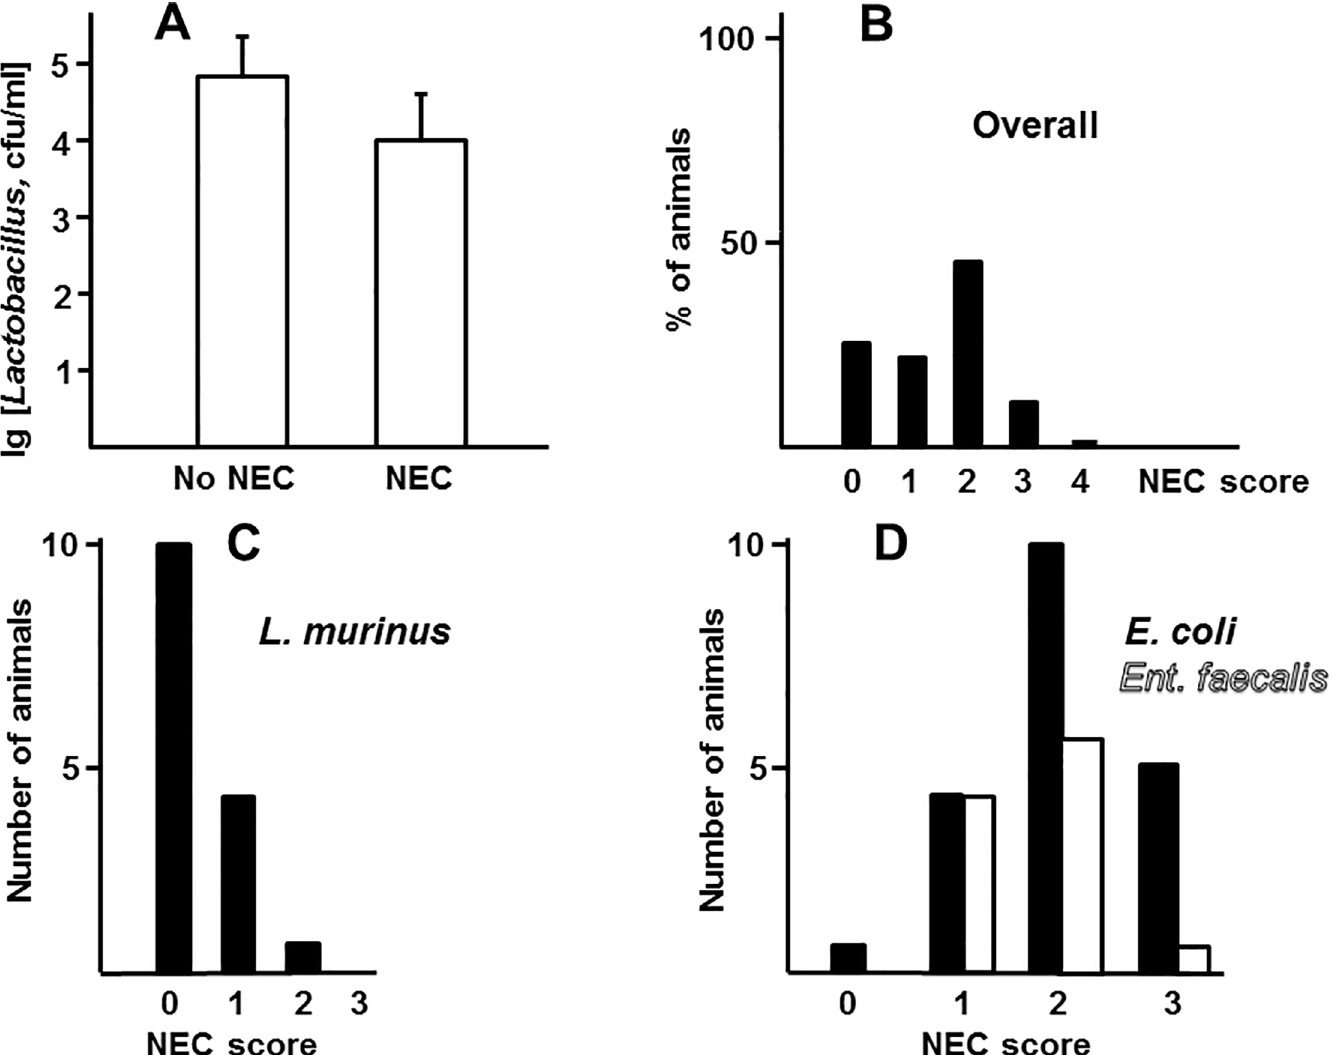
Fig 2. Association of NEC with lactobacilli. A, average logarithms of Lactobacillus loads in healthy (NEC scores 0–1, n = 18) and sick (NEC scores 2–4, n = 28) animals. Differences between groups are not significant, p = 0.36, unpaired Student’s t test. B-D, distribution of NEC scores in the whole study cohort (B, n = 46) and in groups harboring L . murinus (C, n = 15) and E . coli (D, filled bars, n = 20) or Enterococcus faecalis (D, open bars, n = 11) at 25% or more of total bacterial populations. Score distributions in C, but not D, are significantly different from those in B (p values of < 0.001, 0.17, and 0.16 respectively, χ 2 test).